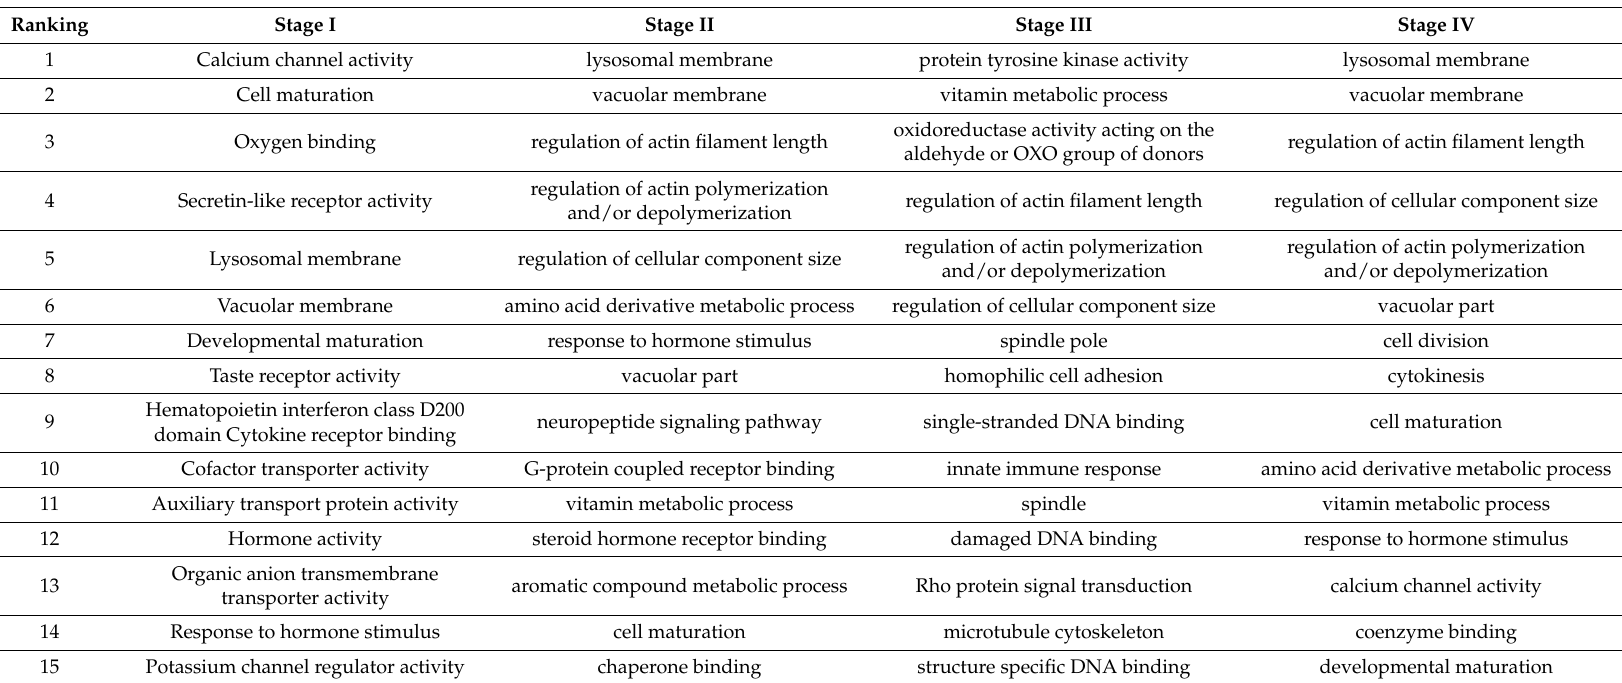
Table 3. The 15 most deregulated gene ontology terms for the four stage groups ranked by their p